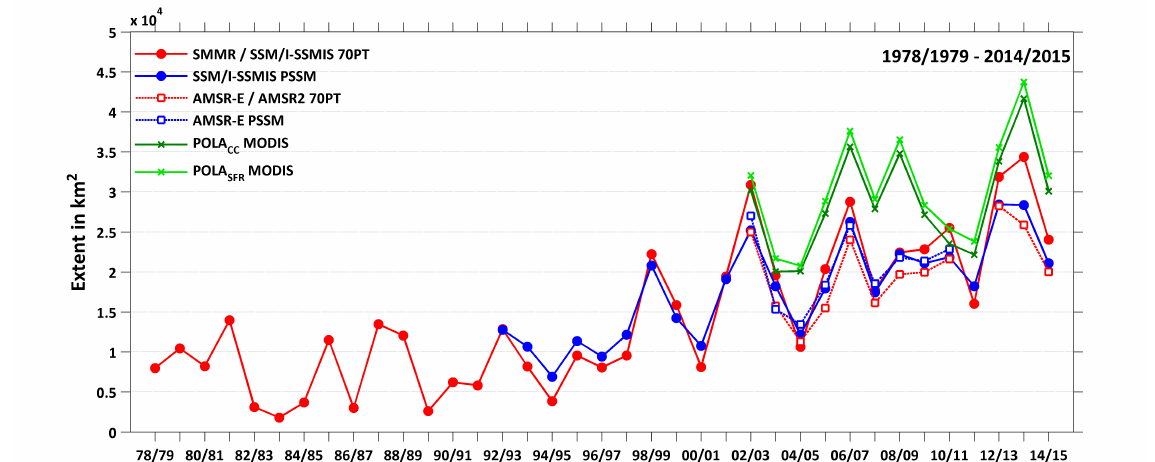
Figure 7. Average wintertime (November to March) polynya area (POLA) for the period from 1978/1979 to 2014/2015. A comparison is made between POLA estimations based on daily MODIS TIT composites (CC: dark green crosses; SFR: light green crosses) and passive microwave sensors (SMMR/SSM/I-SSMIS 70PT: filled red circles; AMSR-E/AMSR2 70PT: unfilled red squares; SSM/I-SSMIS PSSM: filled blue circles; AMSR-E PSSM: unfilled blue